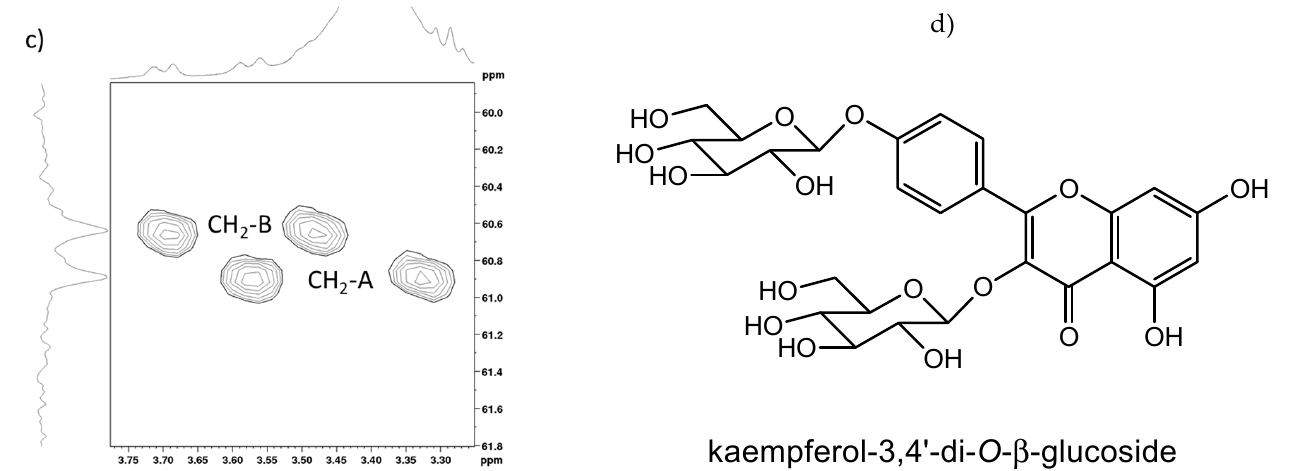
Figure 2. Diglucoside nature of the flavonoid. ( a ) Aromatic region; ( b ) sugar moieties region; ( c ) HSQC expansion of the pyranosidic protons focusing correlations of the two methylenic groups (DEPT135 in vertical F1 projection) and ( d ) complete chemical structure. Table 2. NMR data of kaempferol-3,4 (cid:48) -di- O - β -glucoside (400 MHz, DMSO- d 6, 300 K). Peak d C-13